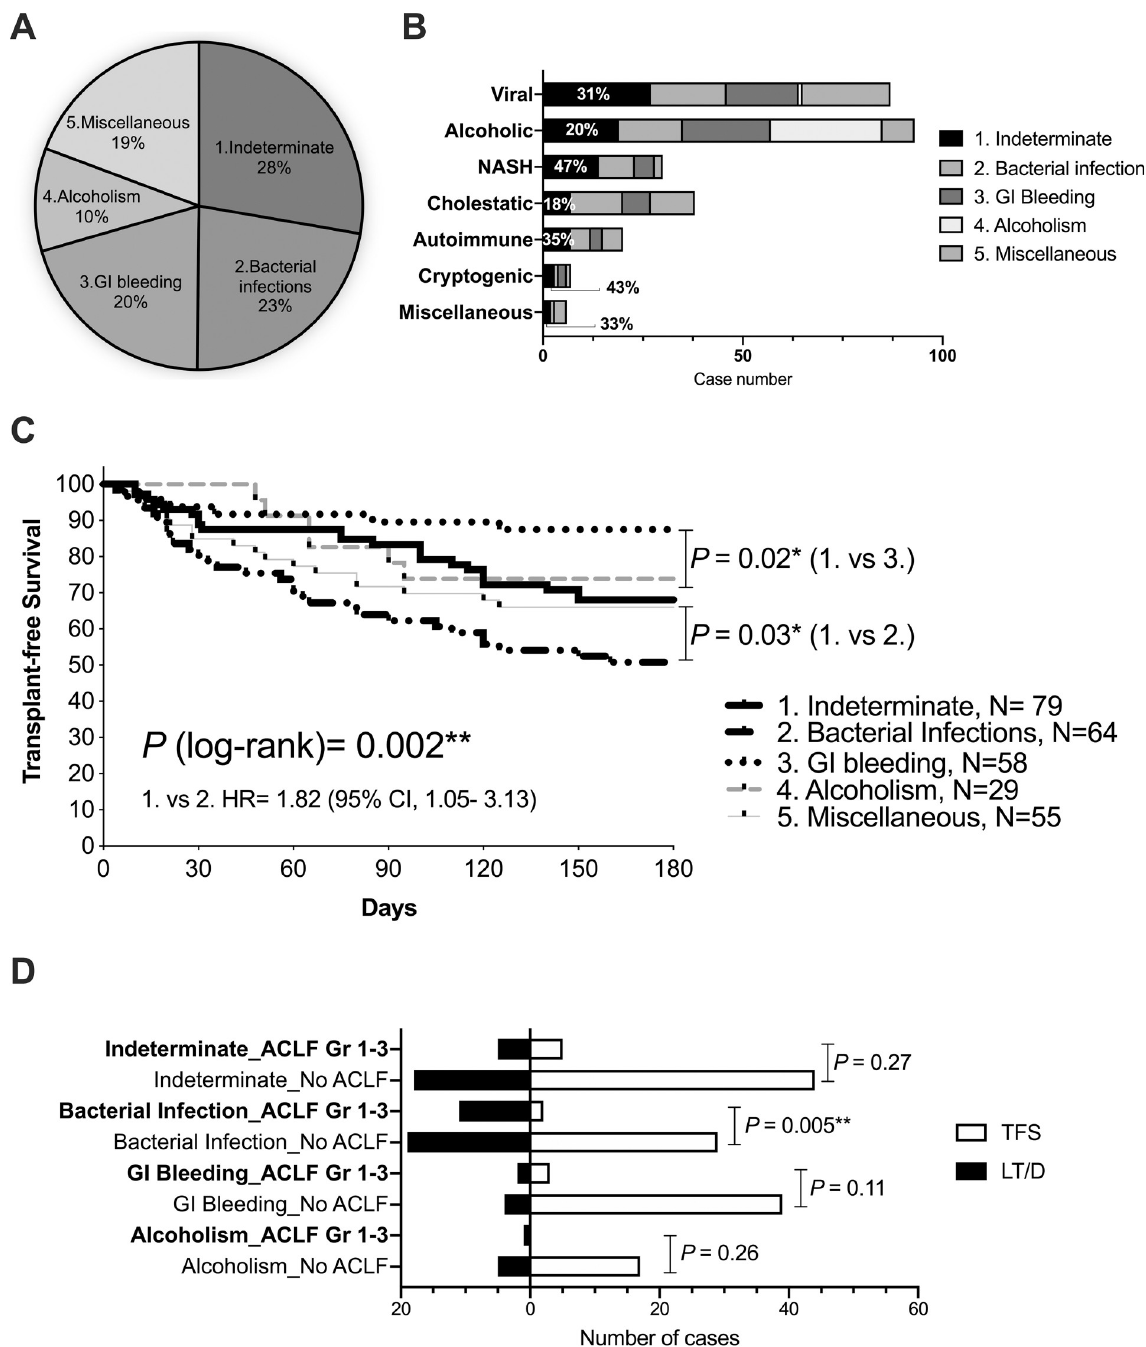
Fig 1. Acute precipitants, background etiologies, survival outcomes, and ACLF grading in the first indexed AD/ACLF. (A) Acute precipitants of the first indexed AD/ACLF (as percentages). (B) Acute precipitants stratified by the etiologies of liver cirrhosis, with percentages showing AD/ACLF IND . (C) Kaplan-Meier analysis was performed for 180-day TFS stratified by acute precipitants. (D) Number of cases for transplant-free survivors (TFS) and liver transplanted /died (LT/D) stratified by acute precipitants and ACLF grading are demonstrated. � P < 0.05; �� P <